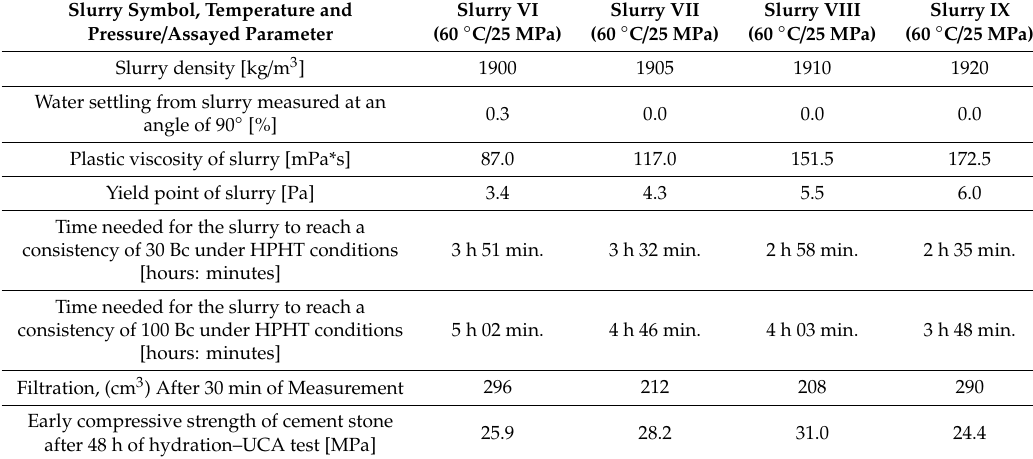
Table 7. The parameters of cement slurries and cement stones with an addition of n-Al 2 O 3 tested under HPHT